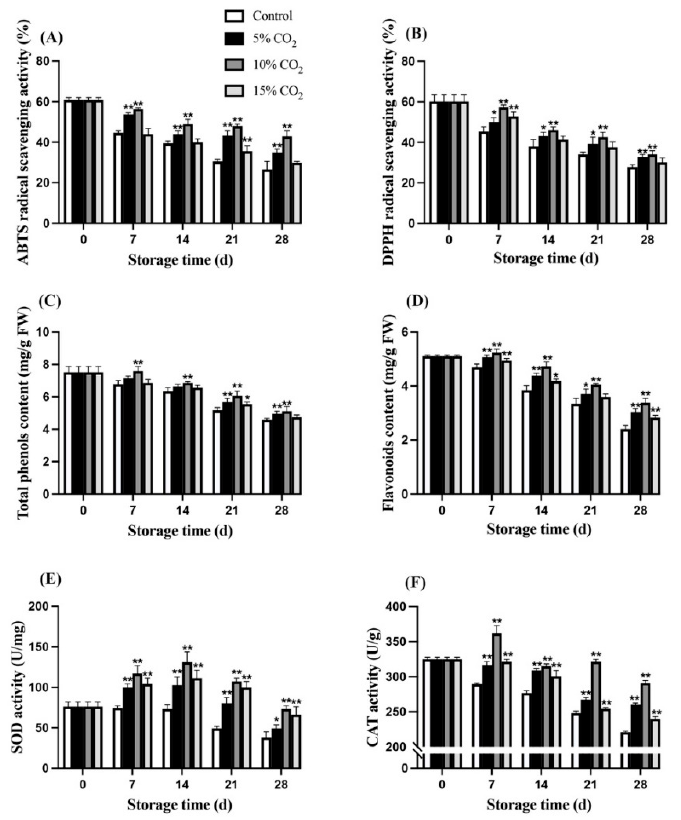
Figure 2. Effects of elevated CO 2 on ABTS (2,2 ′ -azino-bis (3-ethylbenzothiazoline-6-sulfonic acid)) radical scavenging activity ( A ), DPPH (1,1-diphenyl-1-picrylhydrazil) radical scavenging activity ( B ), total phenol content ( C ), total flavonoid content ( D ), SOD (superoxide dismutase) activity ( E ), and CAT (catalase) activity ( F ) of wolfberry during storage at 0 ± 0.5 °C for 28 d. Significant level * p < 0.05; ** p < 0.01.